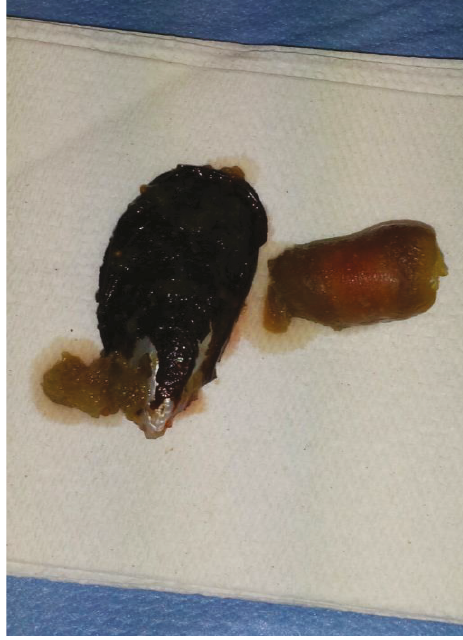
Figure 2: Complete extraction of the foreign